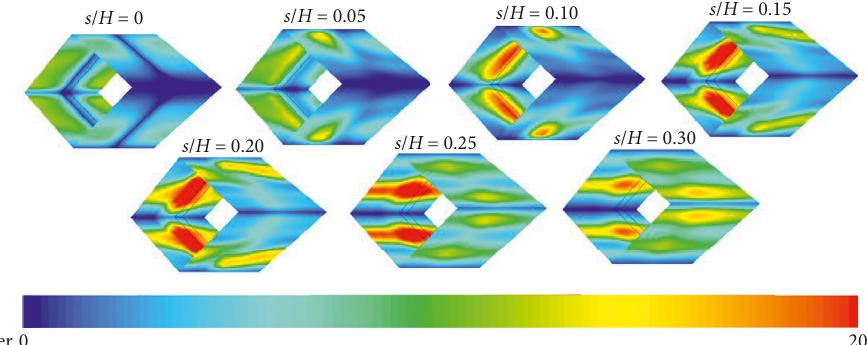
Figure 11: Nu x of the heat exchanger square duct installed with the 45